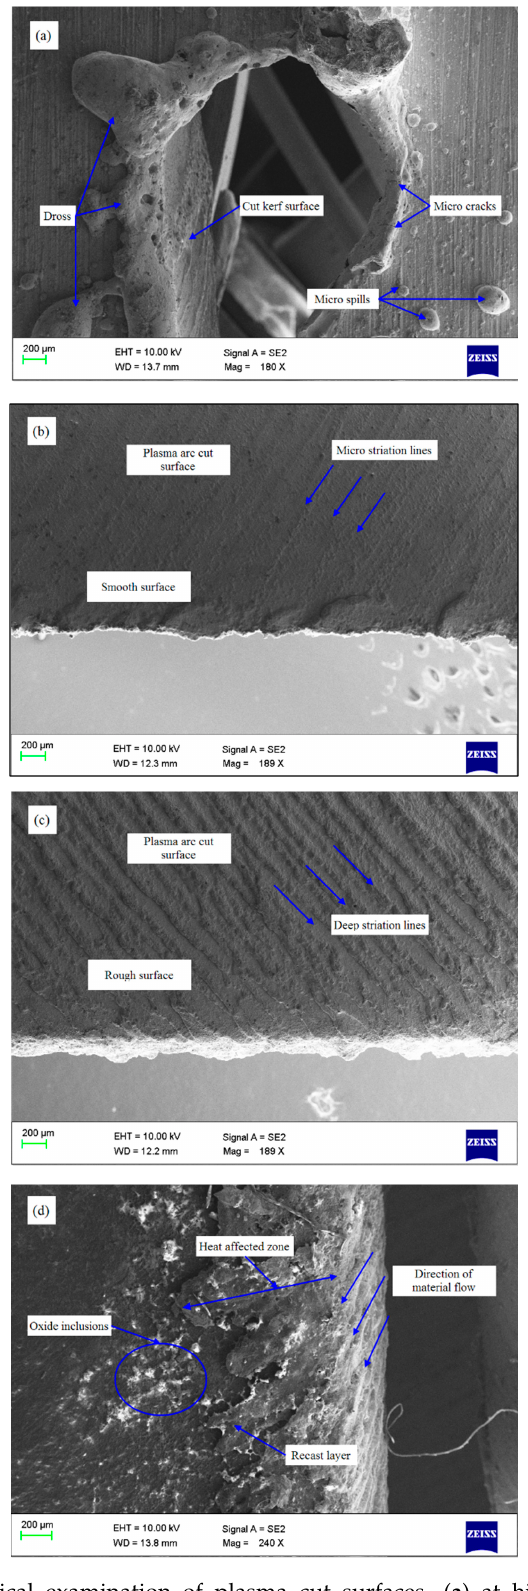
Figure 8. Morphological examination of plasma cut surfaces, ( a ) at higher cutting speed of 2600 mm min − 1 , ( b ) at lower cutting speed (2200 mm min − 1 ) and gas pressure (3 bar), ( c ) and ( d ) at higher stand-off distance of 3 mm.